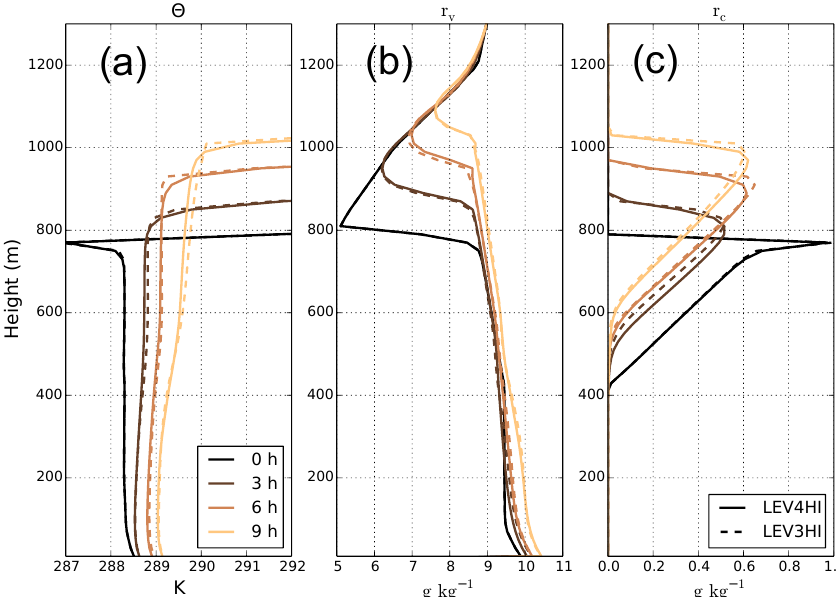
Figure 9. Similar to Fig. 5, but for the experiments LEV3HI and LEV4HI with high aerosol number concentrations.